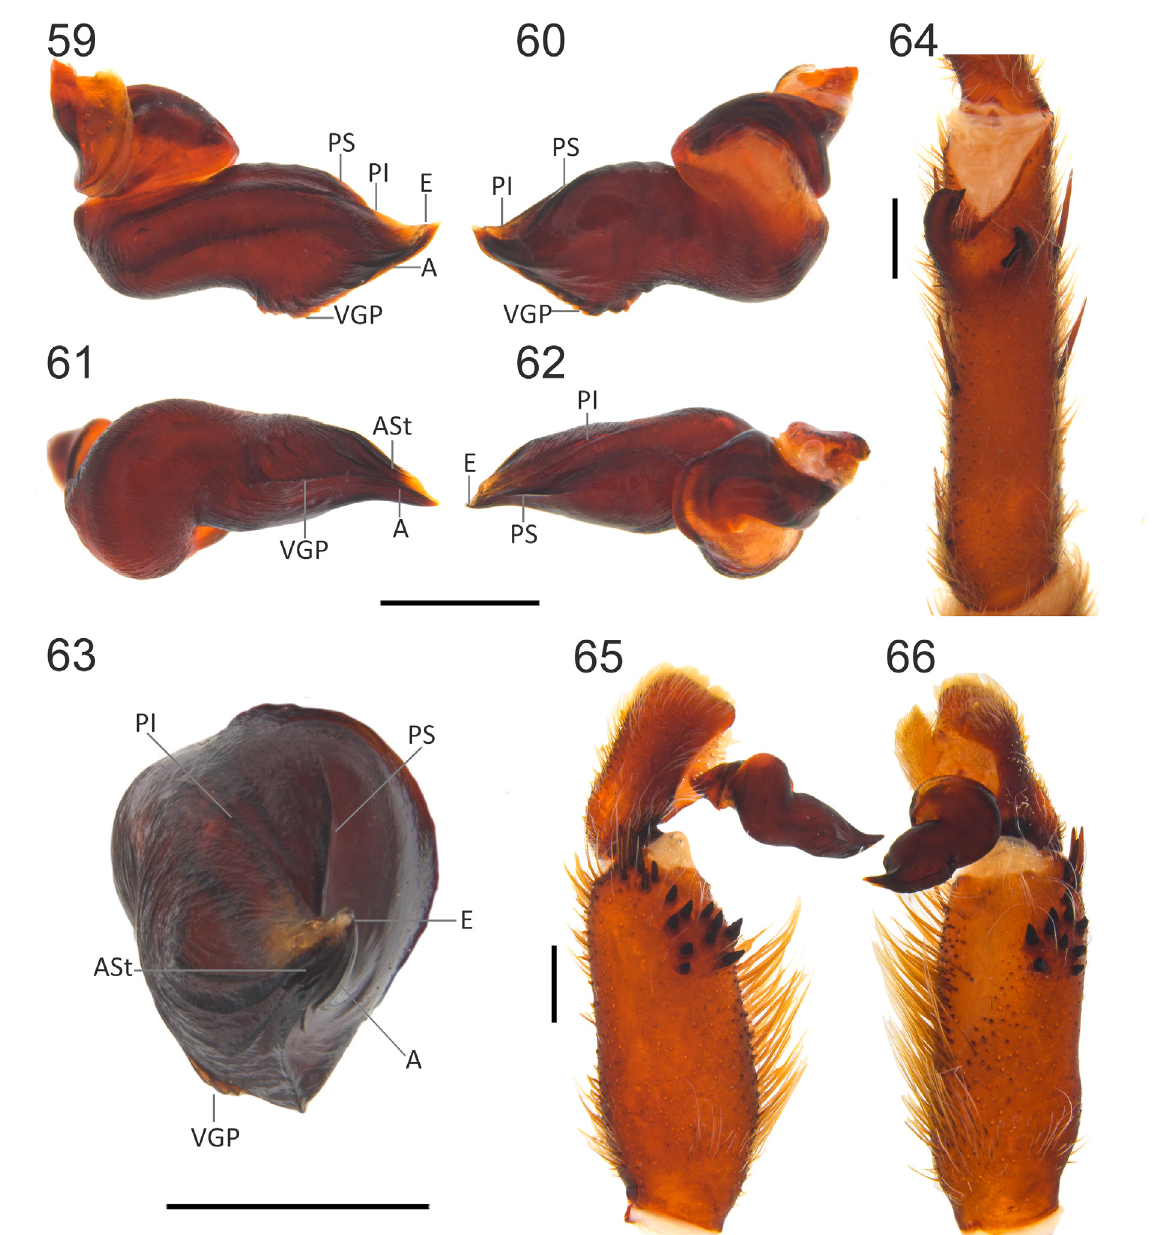
Figs 59–66 . Schismatothele quimbaya sp. nov., holotype, ♂ (MZSP 47524). 59–63 . Palpal bulb, prolateral (59), retrolateral (60), ventral (61), dorsal (62), and frontal (63) views. 64 . Tibial spur ventral view. 65–66 . Palpal tibiae, right (65), and left (66). Abbreviations: A = apical keel; ASt = apical striae; E = embolus; PI = prolateral inferior keel; PS = prolateral superior keel; VGP = ventral granular process. Scale bars = 0.5